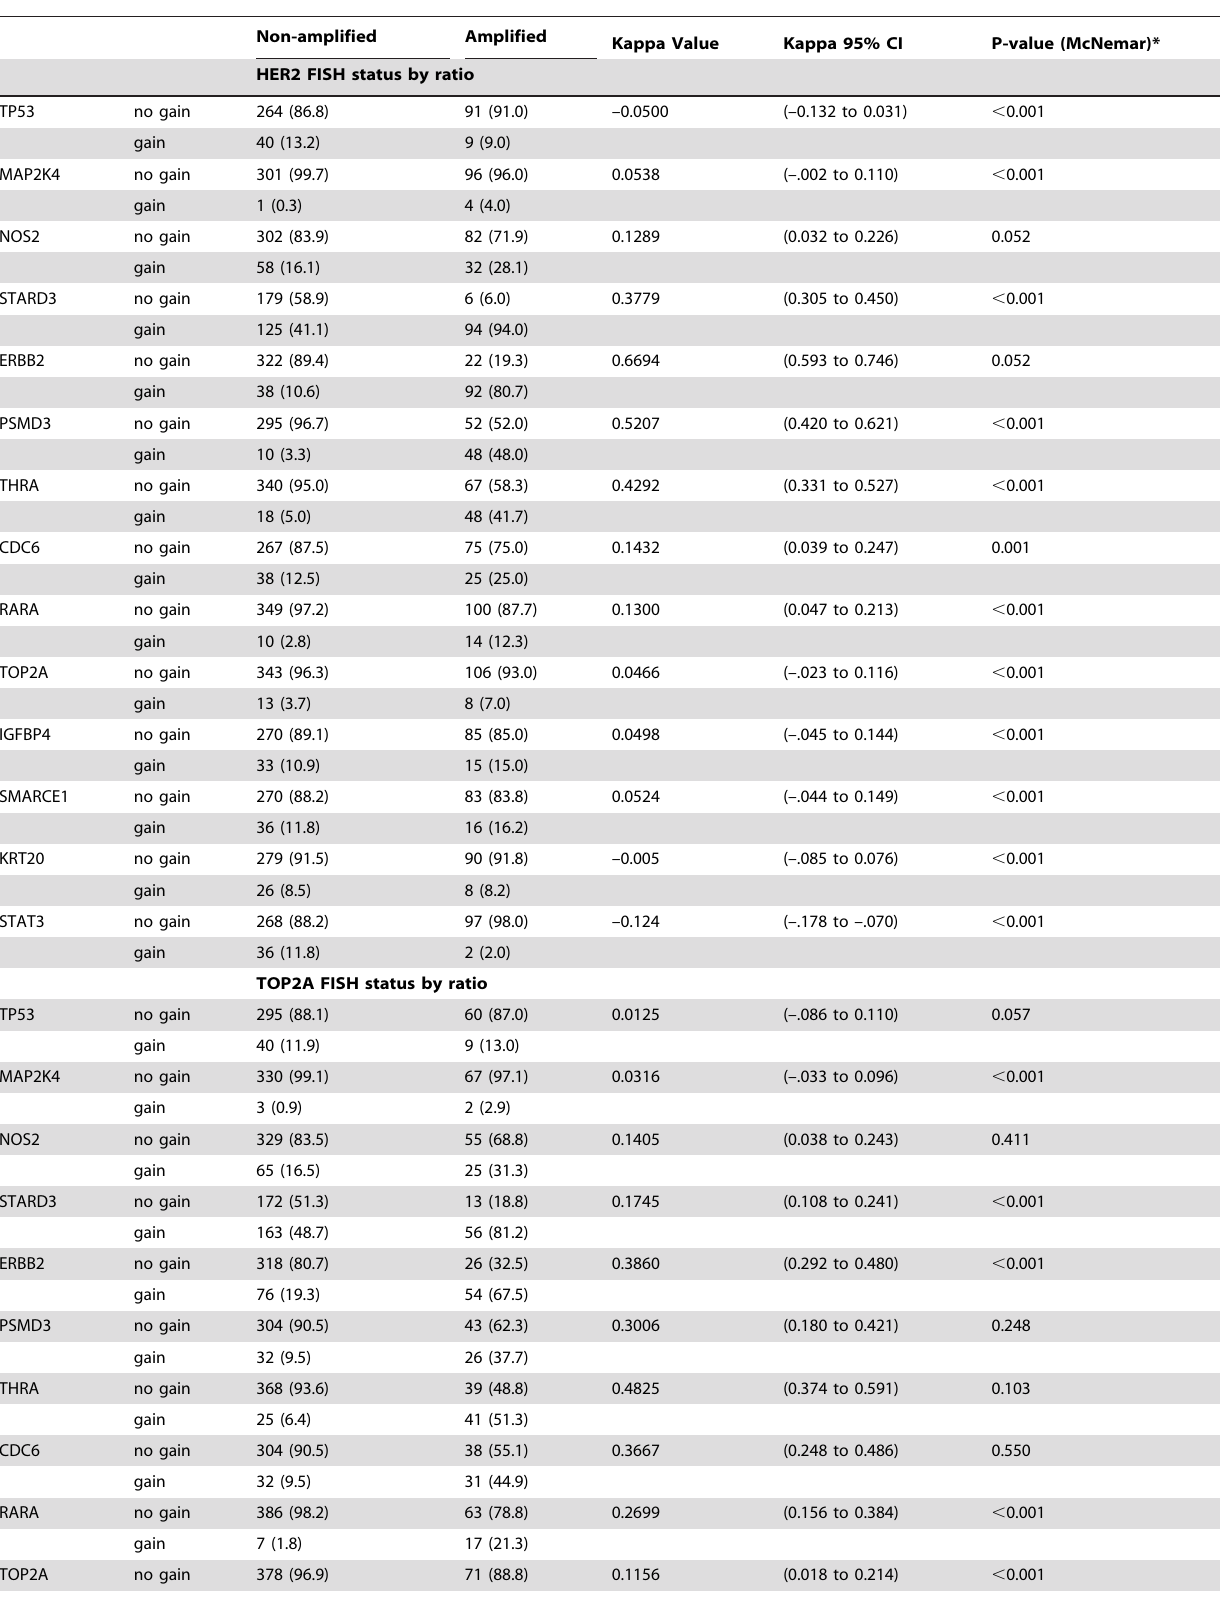
Table 2. Concordance between FISH and qPCR CN classification of chromosome 17 gene status.